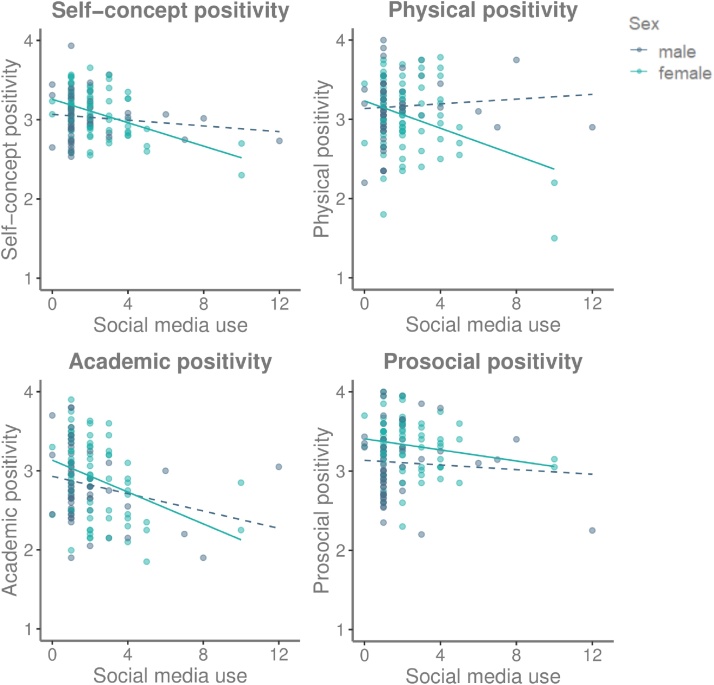
Scatterplots illustrating the relationships between social media use (#hours per day) and positivity of the self-concept, with separate regression lines for boys and girls. The different graphs show the relations for overall self-judgement positivity (across the 3 domains), and for physical, academic and prosocial self-judgement positivity individually.